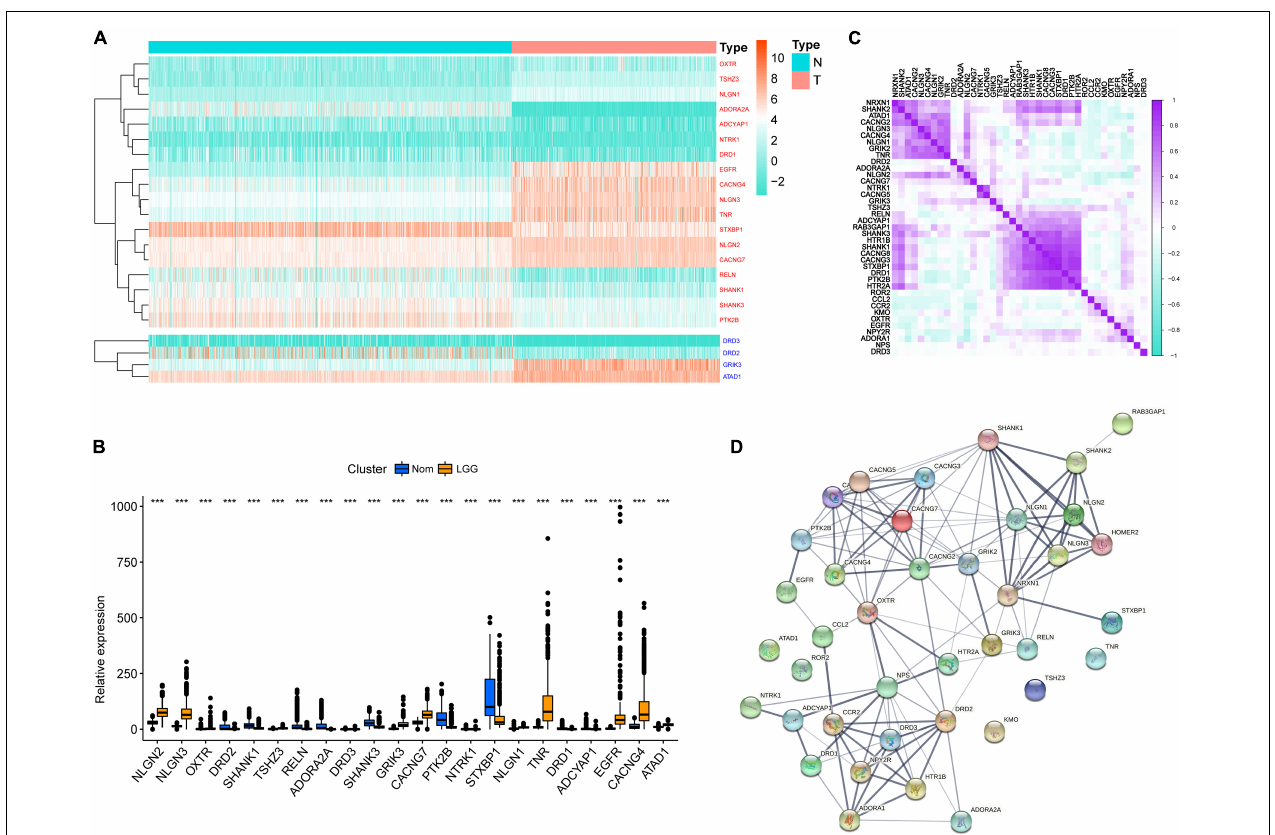
FIGURE 1 | The genomic characterization of glutamatergic synapse-related genes (GSRGs). (A) Heatmap for differentially expressed GSRGs; genes with red color are involved in positive regulation of glutamatergic synaptic transmission, while genes with blue color mainly participate in negative regulation of glutamatergic synaptic transmission. (B) Boxplot for differentially expressed GSRGs. (C) Correlation plot for GSRGs; purple squares indicate positive correlation and turquoise squares indicate inverse correlation. (D) Protein-protein interaction network of GSRGs in STRING database. *** p <